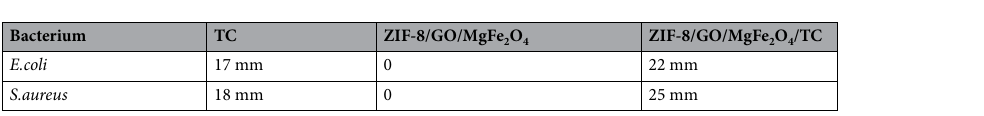
Figure 13. Results of antibacterial tests (a) plate containing Staphylococcus aureus , and (b) plate containing Escherichia coli bacteria.